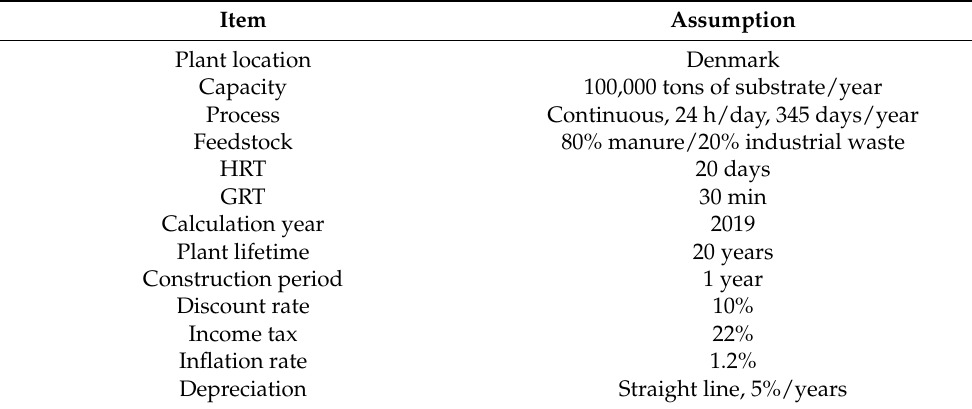
Table 1. Summary of the plant’s characteristics—base